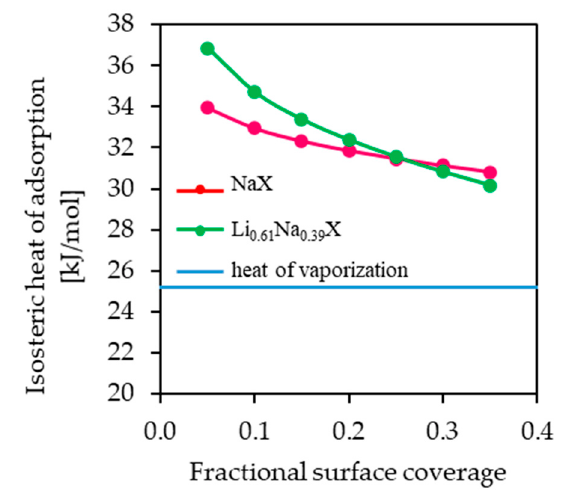
Figure 13. The isosteric heat of adsorption as a function of surface coverage. The horizontal line indicates the heat of vaporization at the boiling point of CO 2 (25.16 kJ/mol).